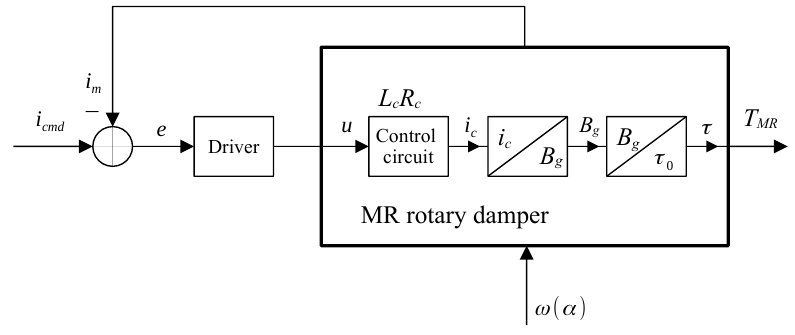
Figure 3. MR rotary damper control